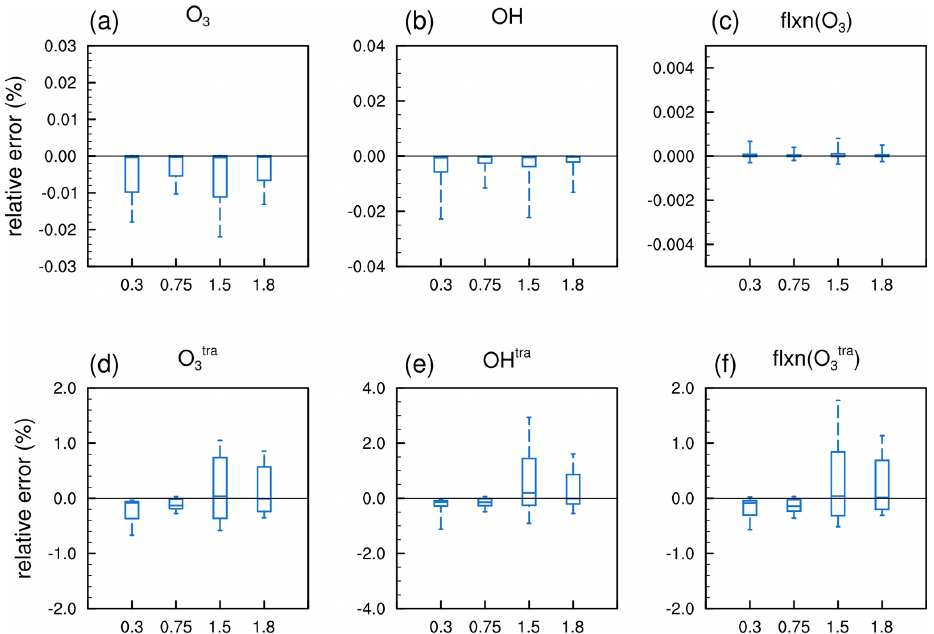
Figure 7. Box plot of the relative errors between the simulations performed with TransClim and EMAC for different emission scalings. The road traffic emissions in North America are scaling with 0.3, 0.75, 1.5 and 1.8. The whiskers show the 5th and 95th percentiles. The relative errors for the variables O 3 (a) , OH (b) and flxn(O 3 ) (c) as well as the contributions O tra O 3 and O tra , the relative errors of the tropospheric columns are shown. For OH and OH tra , the deviations of the tropospheric means are 3 displayed. For flxn(O 3 ) and flxn(O tra ), the values at the top of the atmosphere are taken into account. 3